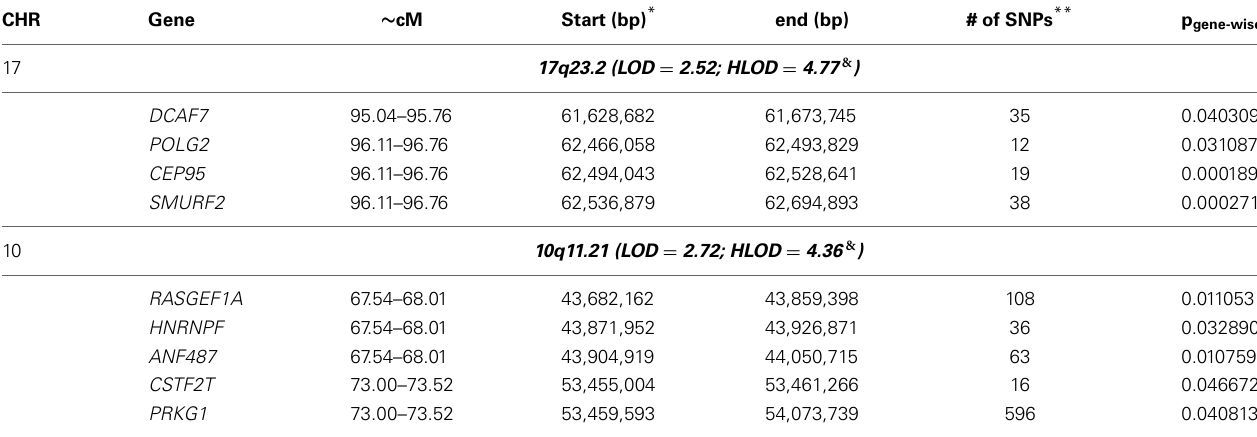
Table 4 | Association of leukocyte telomere length and candidate genes under the significant linkage signals. CHR Gene